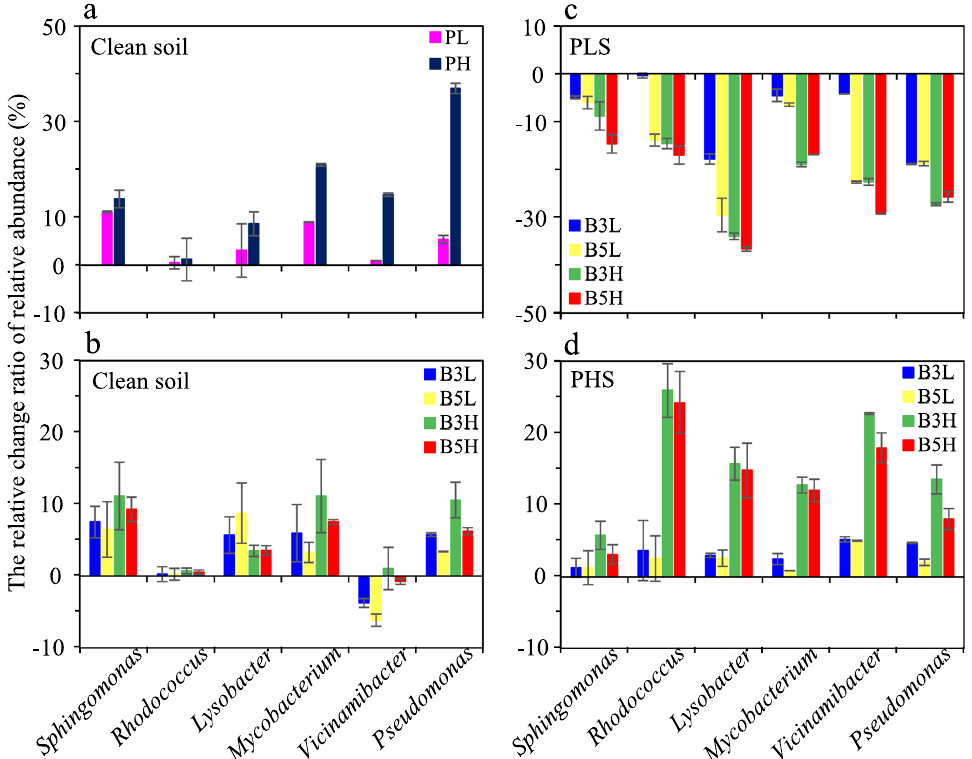
Fig. 4 Percentage change in the relative abundance of 6 genera associated with mineralization under phenanthrene exposure ( a ) or biochar amendment in the clean soil ( b ), PLS ( c ) and PHS ( d ) for 28 days. PL and PH indicate soil spiked with low (2 mg kg − 1 ) and high (20 mg kg − 1 ) concentrations of phenanthrene alone, respectively. BnL and BnH indicate soil amended with low (0.03%) and high (0.3%) doses of biochar, respectively. “n” indicates charring temperatures of 300 and 500